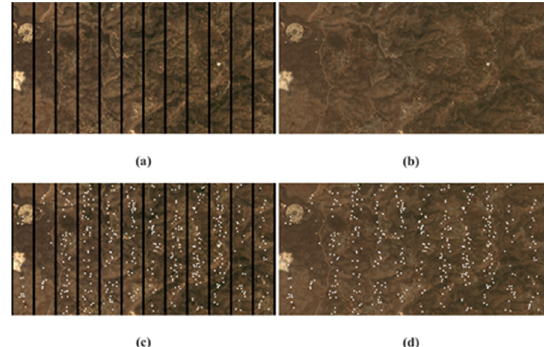
Figure 9. RGB composition of the spectral images used in Experiment 4: ( a ) Landsat8, with simulated missing-data stripes and ( b ) Sentinel 2 A. The white dots in ( c ) and ( d ) represent the IPs detected in this pair of images, respectively.